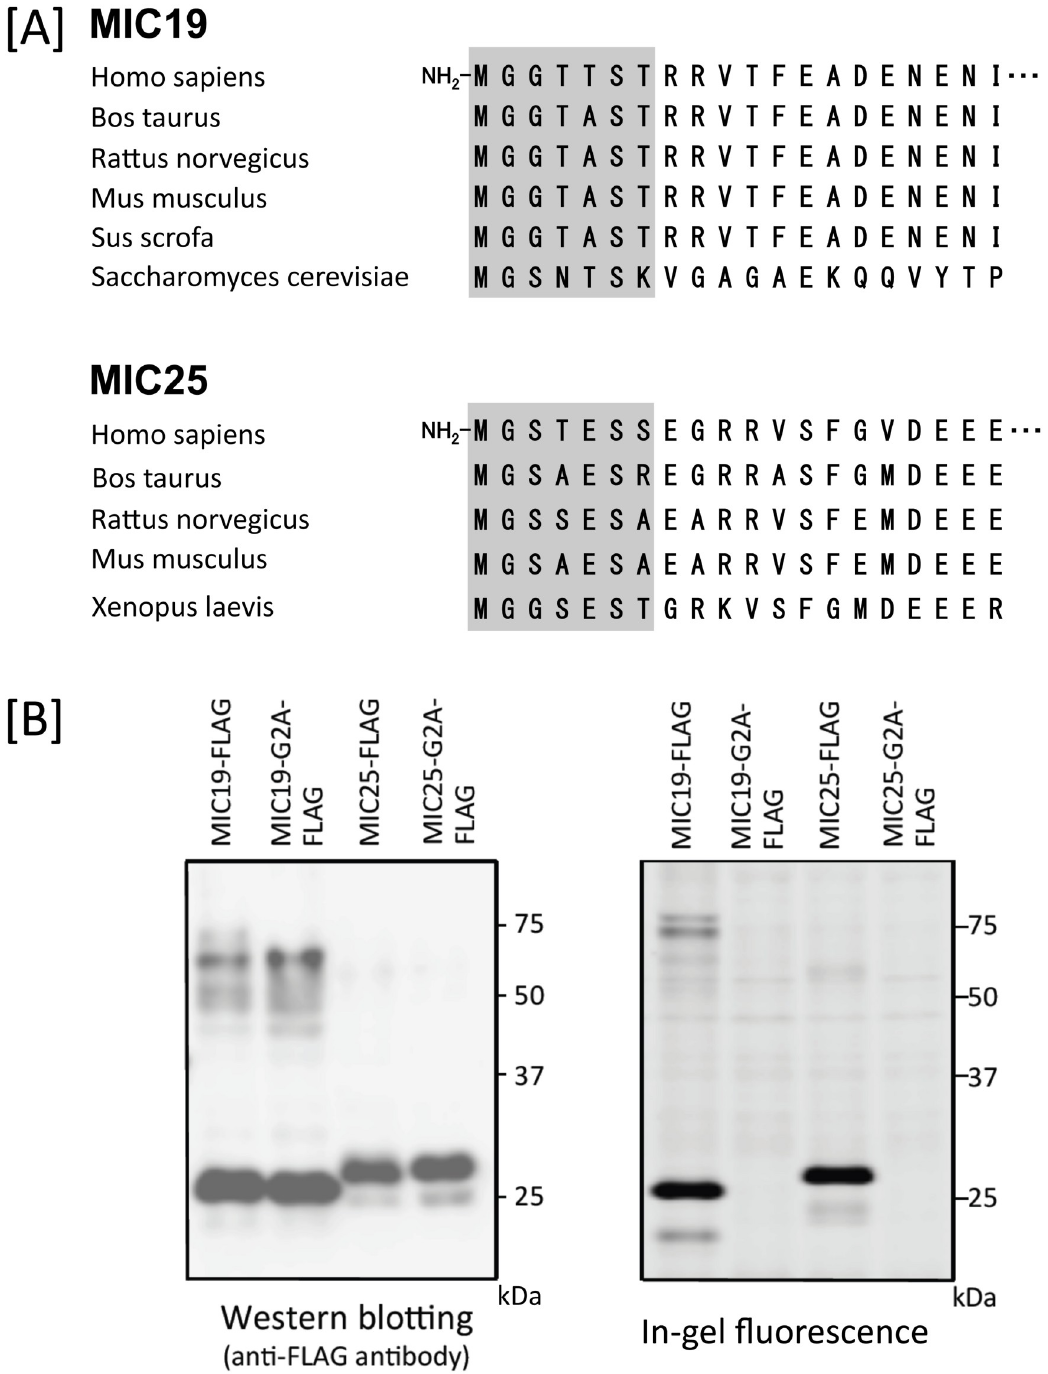
Fig 6. Detection of protein N -myristoylation occurring on human MIC19 and MIC25 by cellular metabolic labeling. A. Interspecies alignment of the N-terminal sequences of MIC19 and MIC25. N -myristoylation motifs are shown in grey in the N- terminal sequences. B. cDNAs encoding MIC19-FLAG, MIC25-FLAG, and their G2A mutants were transfected into COS-1 cells. The expression of proteins was evaluated by western blotting analysis using anti-FLAG antibodies. Protein N -myristoylation was evaluated by metabolic labeling with a myristic acid analog followed by click chemistry, as described in the Materials and methods.